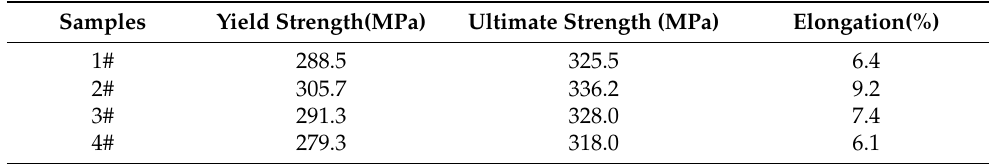
Figure 10. ( a – d ) The tensile engineering stress-strain curves of four samples prepared by laser cladding using four powders. Table 4. The yield strength, ultimate strength, and elongation of four samples which prepared by laser cladding using four powders.